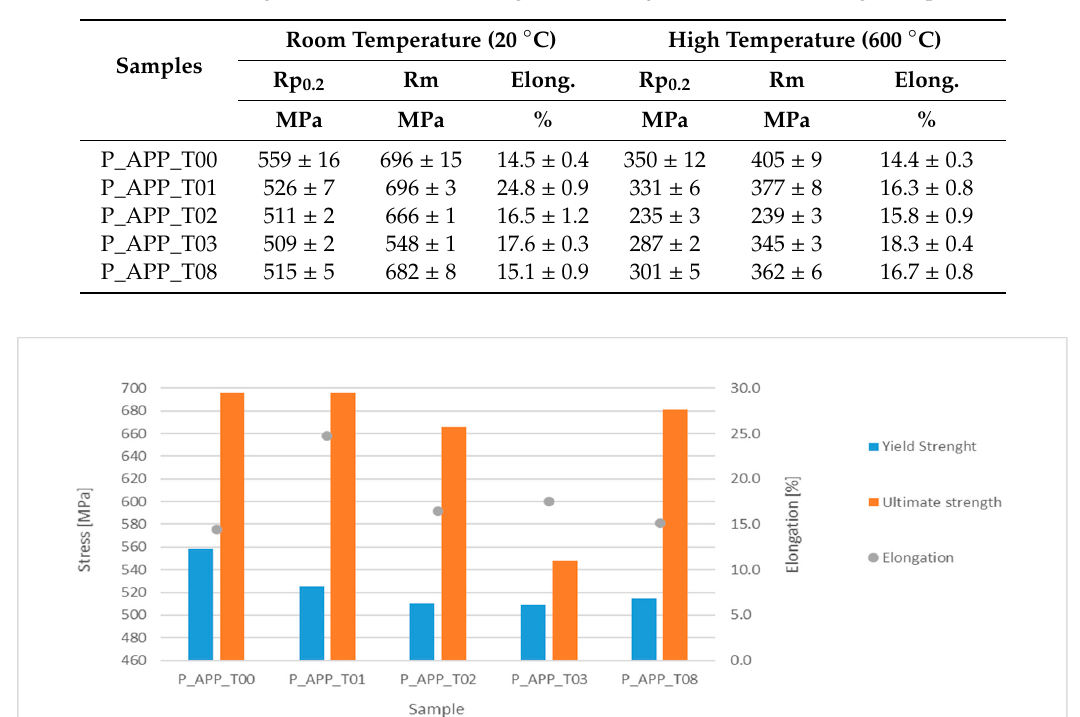
Figure 9. Results of the tensile tests performed at room temperature.